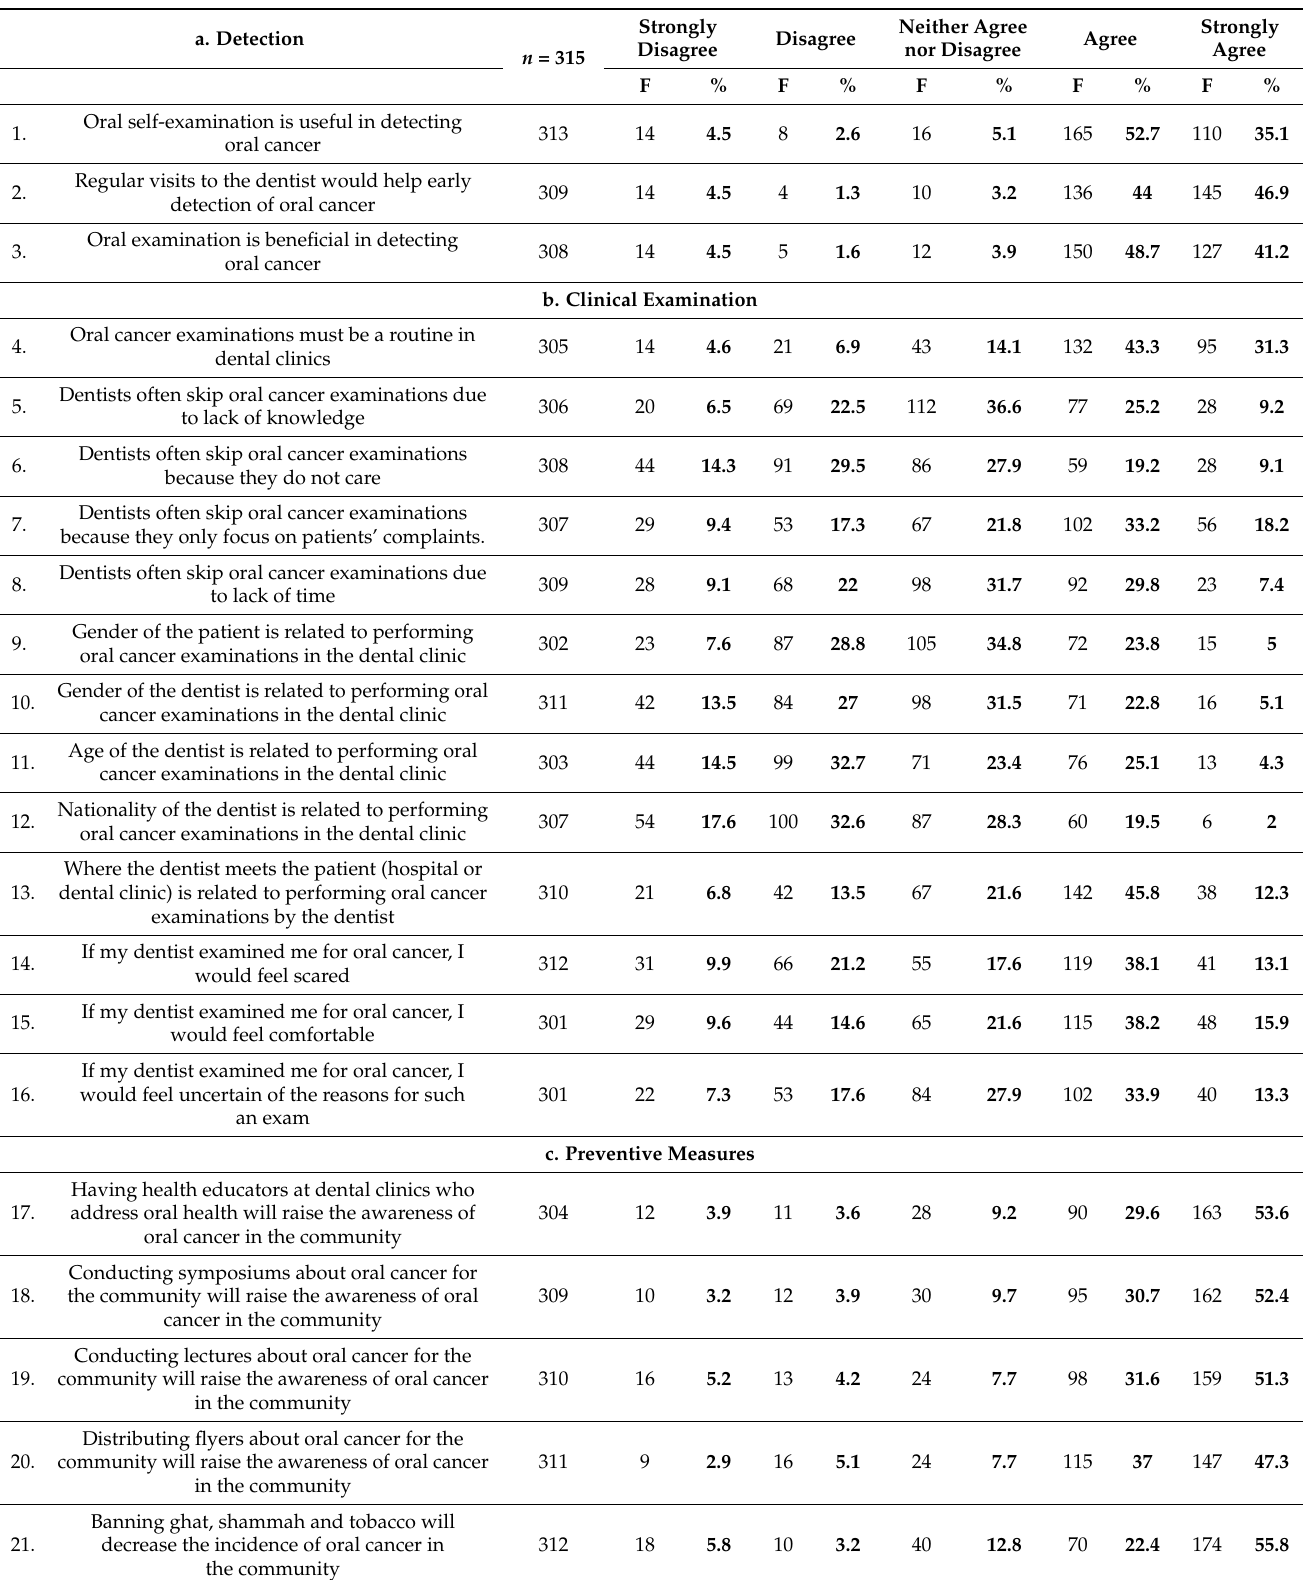
Table 3. Dental patients’ perception toward oral